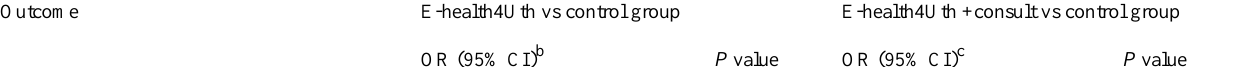
Table 4. Stratified analyses of intervention effects on health behavior for the various levels of the significant moderator variables. a